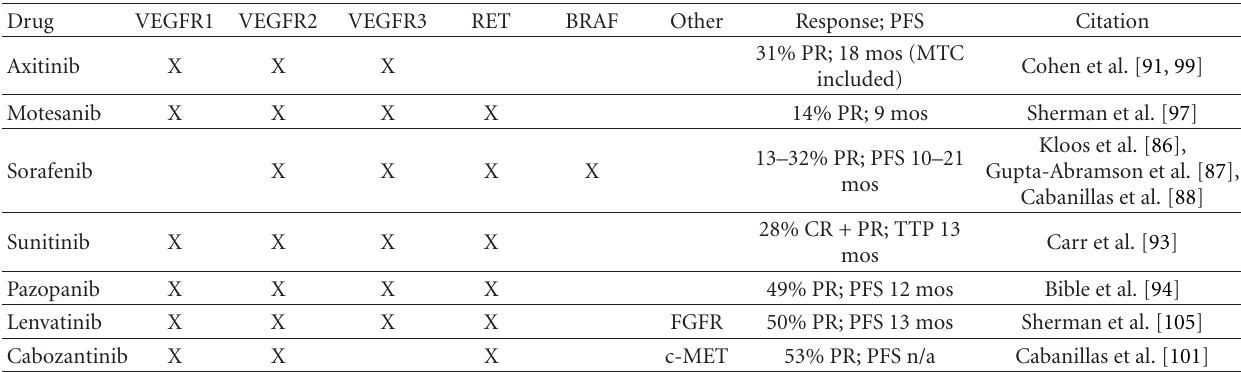
Table 3: Targeted therapies evaluated in clinical trials for thyroid